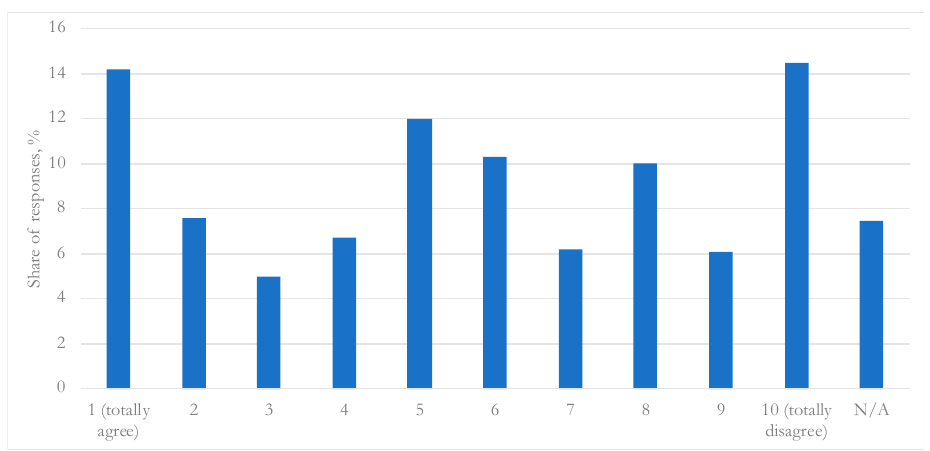
Figure 6. Survey responses on whether it is worth participating in the insulation of respondents’ homes (“I am ready to support the initiative of my neighbours, not to initiate it myself”).